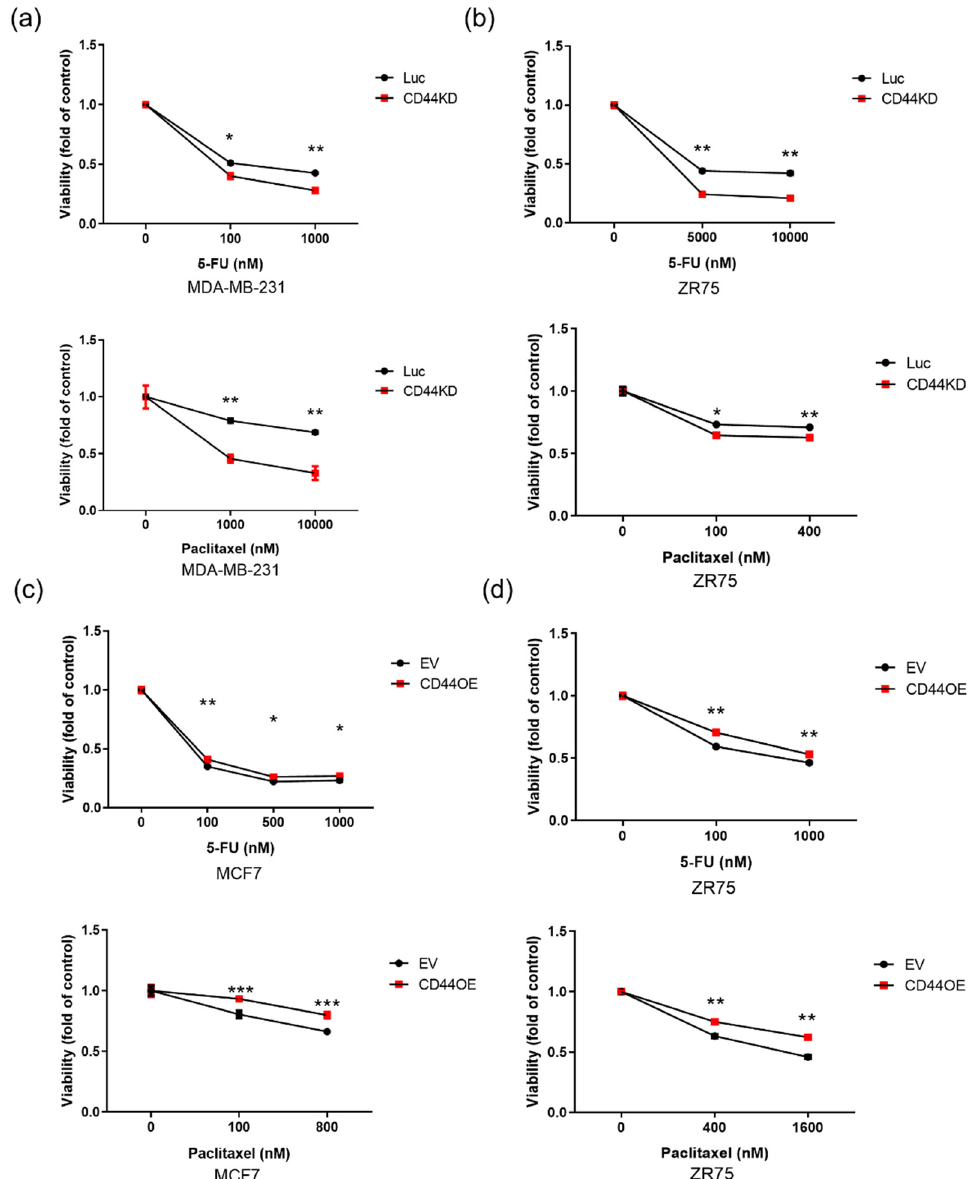
Figure 4. CD44 facilitates multiple drug resistance in breast cancer cells: ( a , b ) Effects of 5-FU and paclitaxel on CD44 knockdown MDA-MB-231 and ZR75 cells. ( c , d ) Effects of 5- FU and paclitaxel on CD44 overexpressed MCF7 and ZR75 cells. Two-way ANOVA was performed for the statistical analysis. The data are presented as the mean ± SD. * Indicates p < 0.05, ** indicates p < 0.01, and *** indicates p <